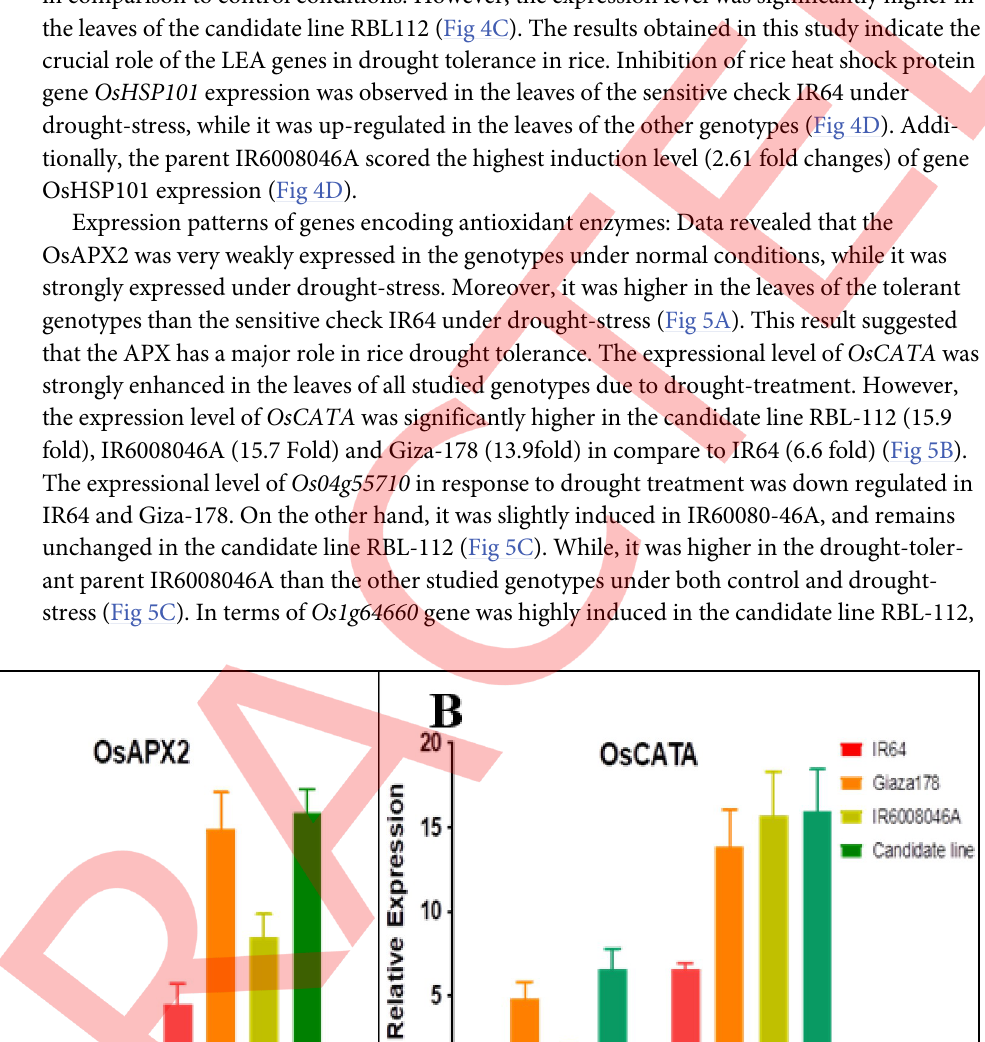
PLOS ONE | https://doi.org/10.1371/journal.pone.0266087 March 29,